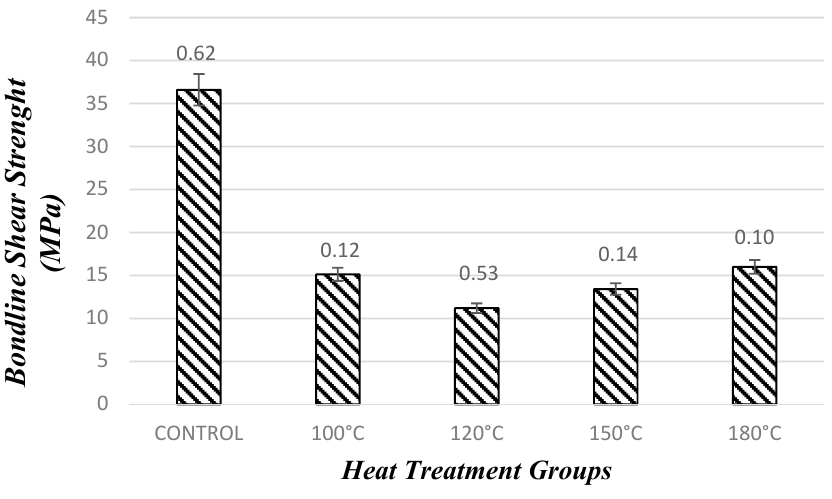
Figure 9. Adhesive bondline shear strength values of the samples after densification process.